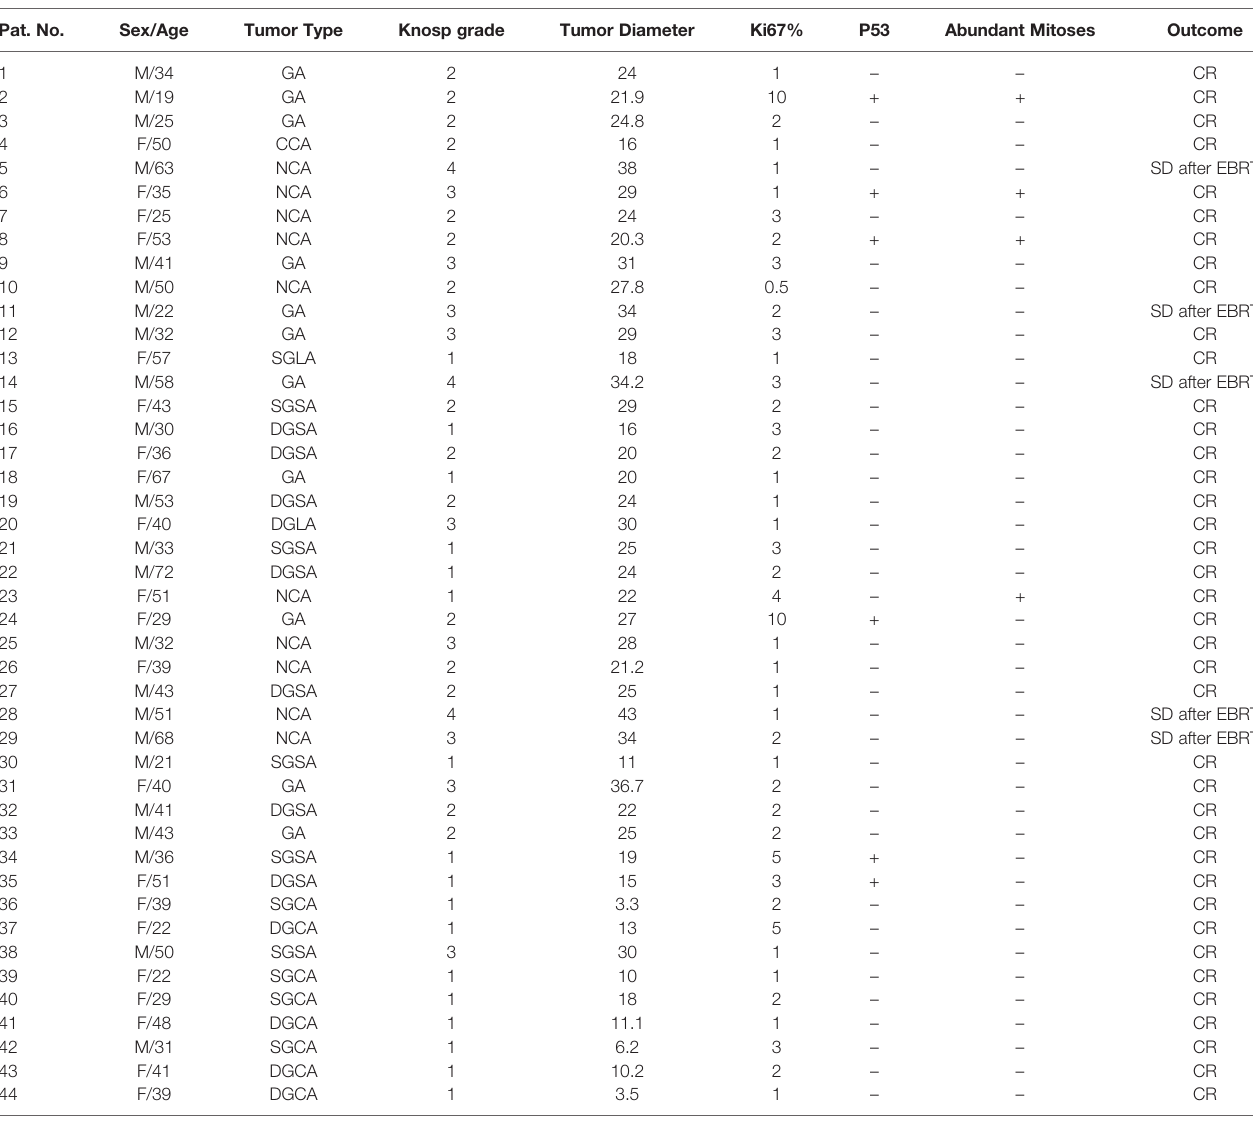
TABLE 2 | Clinical and immunohistochemical characteristics of the 44 non-refractory Pas. Pat.